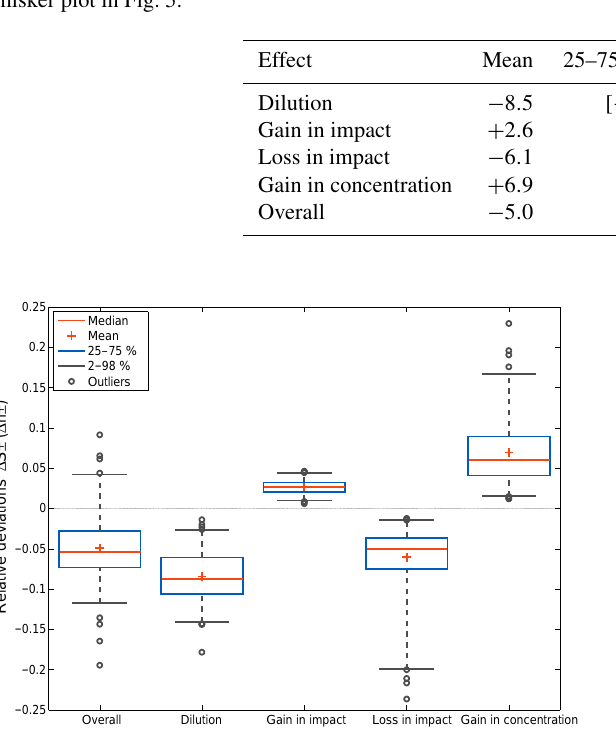
Figure 5. Box-and-whisker plot for the overall differences in emis- sion sensitivity and the contributions of the different effects in ref- erence to the 300m assumption based on 216 simulations. The whisker ends are defined by the 2nd and 98th percentile and the remaining outliers are considered by outlying circles.